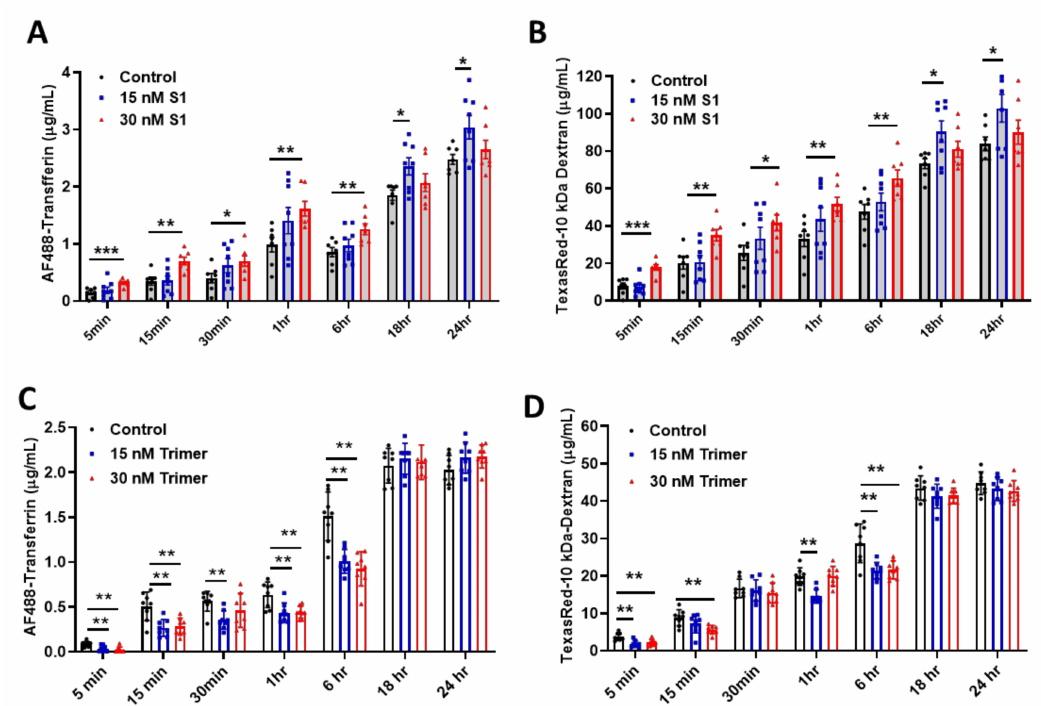
Figure 3. The permeability of molecular delivery is impaired by the treatment of the spike proteins in the human brain ECs. ( A , B ) Permeability tests were performed with the treatment with 15 nM (blue) or 30 nM (red) of S1 domain of spike protein (S1) each along with of human AF488-Transferrin (10 µ g/mL) ( A ) and TexasRed-10 kDa-Dextran (250 µ g/mL) ( B ) at different time points on the upper chamber. Data were quantified by unpaired student t -tests and means with SD (N ≥ 7). ( C , D ) 15 nM (blue) or 30 nM (red) of active trimer domain of spike protein (Trimer) was treated each along with AF488-Transferrin (10 µ g/mL) ( C ) and TexasRed-10 kDa-Dextran (250 µ g/mL) ( D ). Data were quantified by unpaired student t -tests, and error bars show means with SD (N ≥ 7). * p < 0.05; ** p < 0.01; *** p <